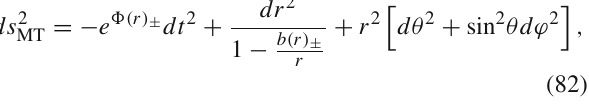
Fig. 4 The trend of the g χχ metric component of the line element (71) versus